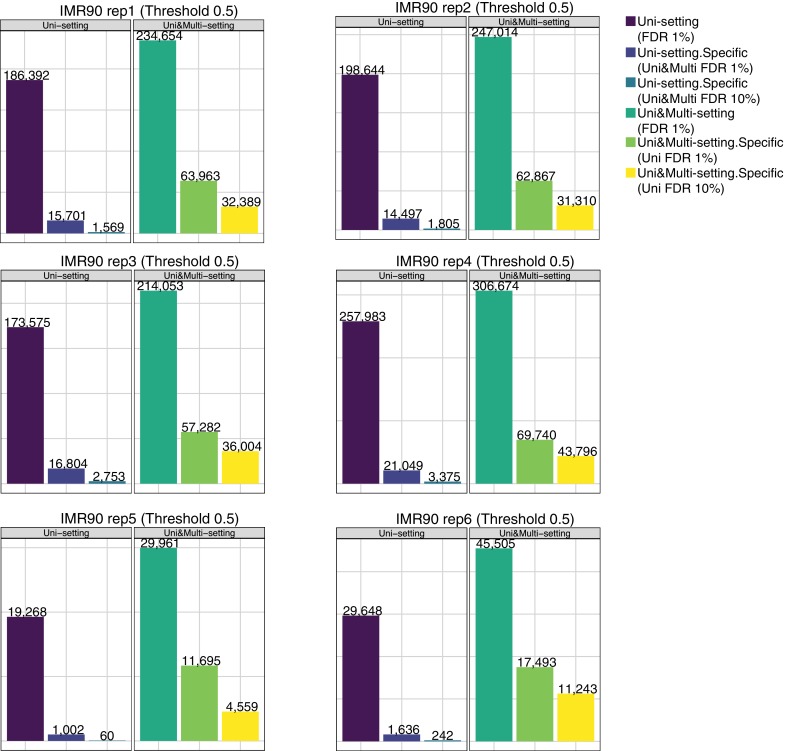
Recovery of significant interactions identified at FDR 1% by analysis at FDR 10% for each of six replicates of IMR90 at 40 kb.Uni&Multi-setting. Specific (Uni FDR 10%) is the set of significant interactions identified at 1% FDR by the Uni&Multi-setting but are still unrecoverable by the Uni-setting even with a liberal FDR of 10%. The detailed descriptions of the groups are as follows: Uni-setting (FDR 1%): # of significant interactions identified by the Uni-setting at 1% FDR. Uni&Multi-setting (FDR 1%): # of significant interactions identified by the Uni&Multi-setting at 1% FDR. Uni-setting.Specific (Uni&Multi FDR 1%): # of significant interactions identified by Uni-setting (FDR 1%) but not by Uni&Multi-setting at 1% FDR. Uni-setting.Specific (Uni&Multi FDR 10%): # of significant interactions identified by Uni-setting (FDR 1%) but not by Uni&Multi-setting at 10% FDR. Uni&Multi-setting.Specific (Uni FDR 1%): # of significant interactions identified by Uni&Multi-setting (FDR 1%) but not by Uni-setting at 1% FDR. Uni&Multi-setting.Specific (Uni FDR 10%): # of significant interactions identified by Uni&Multi-setting (FDR 1%) but not by Uni-setting at 10% FDR.